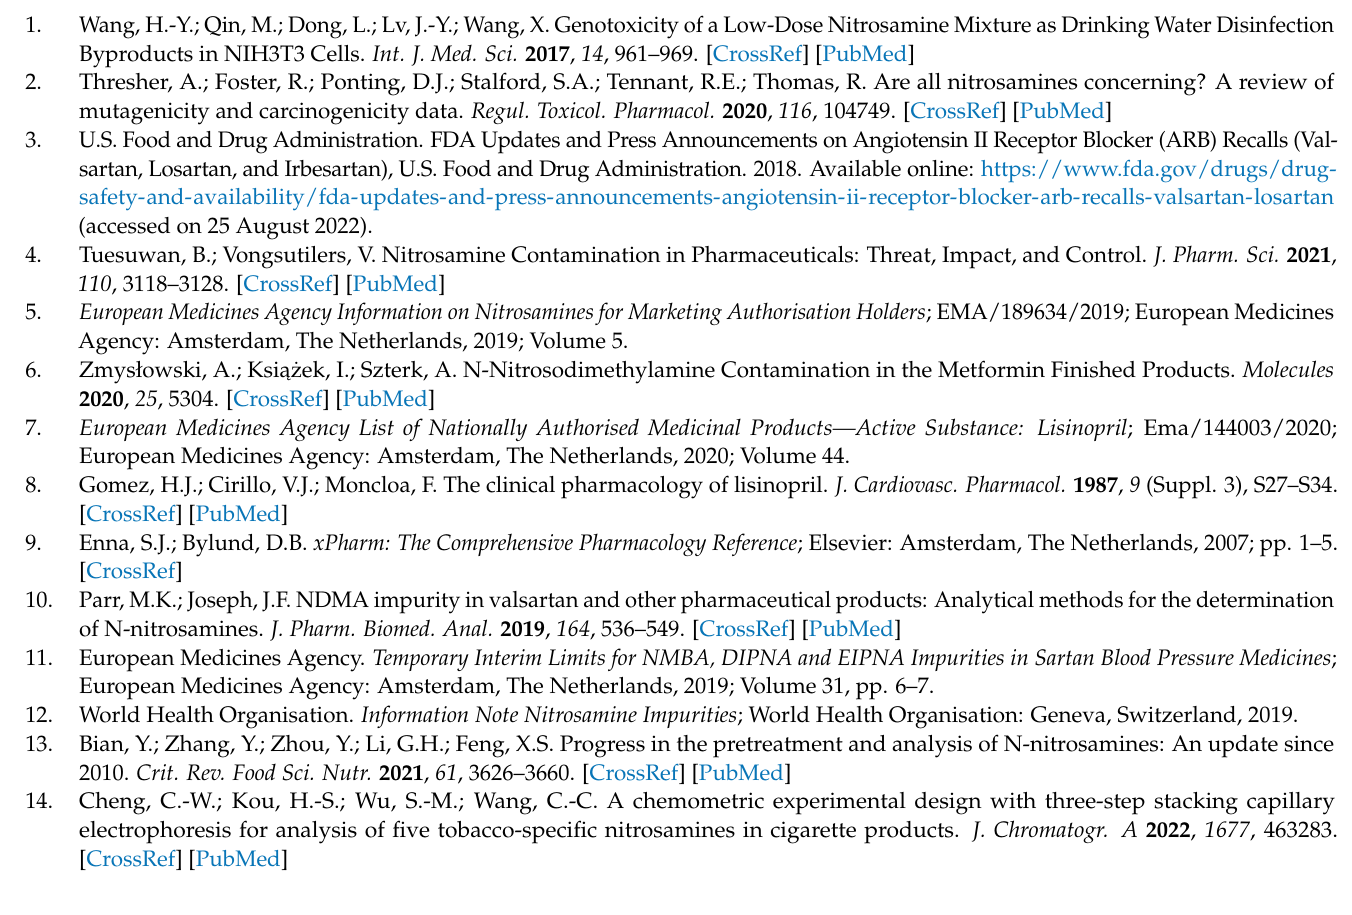
Table S1: Differences between the present approach and Boczar et al. [19] methodology; Table S2: Conducted experiments and measured responses for “Crossed D-Optimal” (CDO)